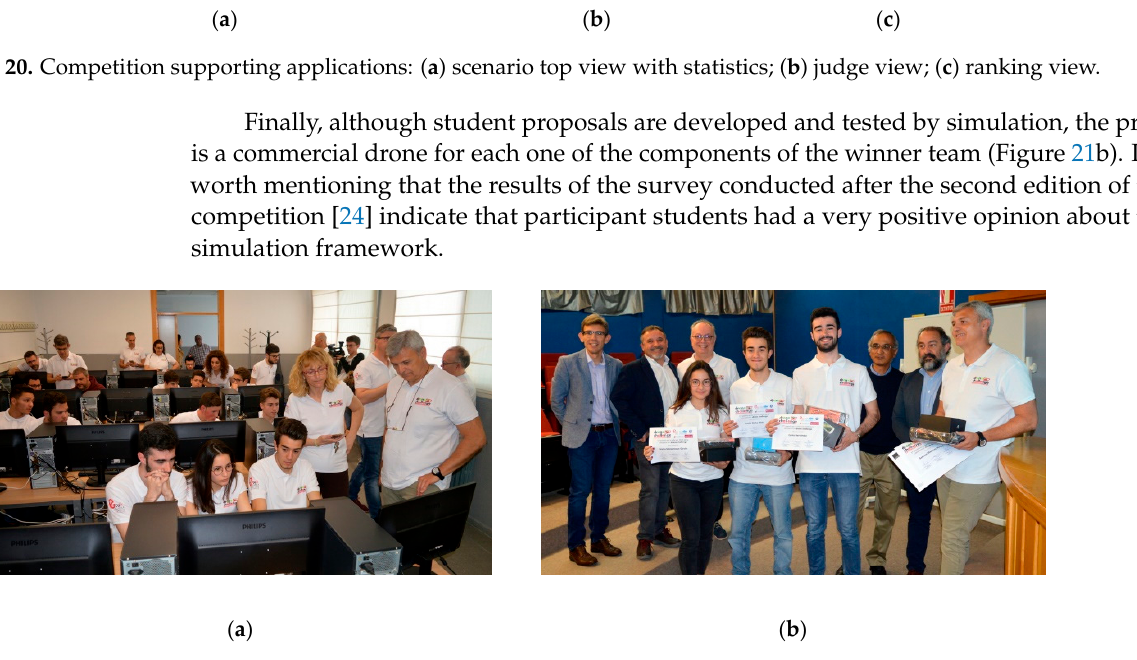
Figure 21. Different moments of the competition: ( a ) judges evaluating student proposals; ( b ) award ceremony.